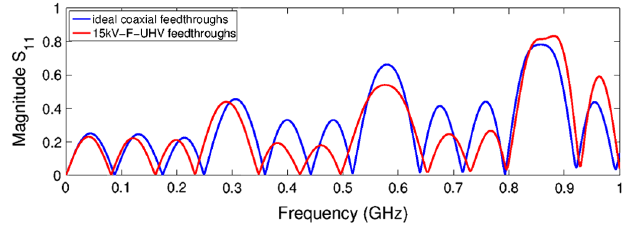
FIG. 18. Predicted magnitude of S 11 for half-moon electrode striplines with ideal coaxial feedthroughs and with Kyocera 15kV-F-UHV